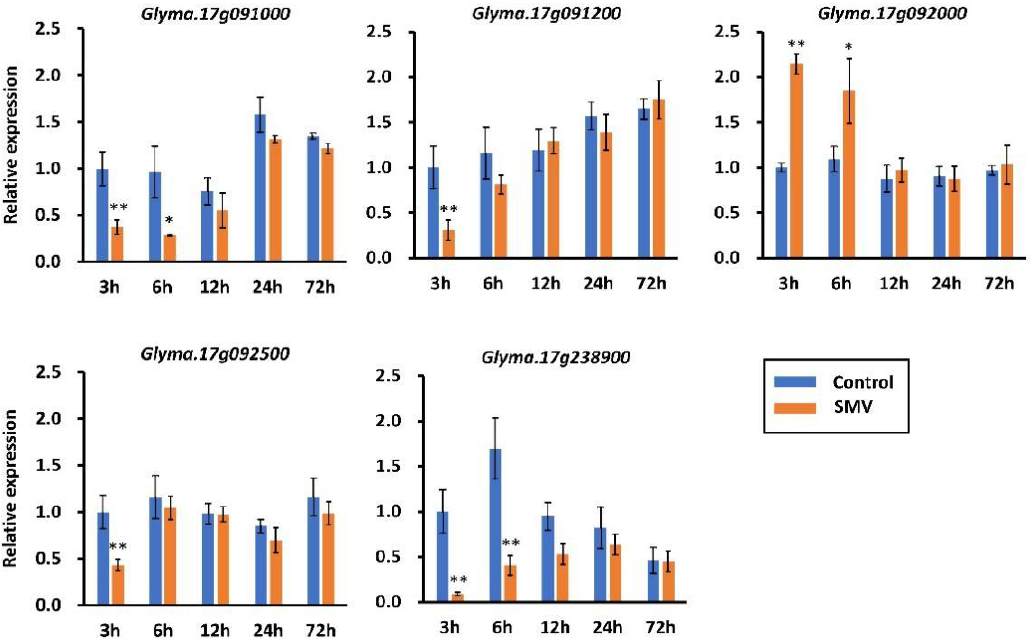
Figure 4. Expression profiling of candidate genes for resistance to seed coat mottling in soybean cultivar SN14 in response to SMV N3 strain. The y -axes indicate the relative expression levels between samples infected with SMV and control samples inoculated with PBS buffer; the x -axes indicate the time points post-inoculation; the * and ** indicate significant differences at p < 0.05 and p < 0.01, respectively, based on Student’s two-tailed t -test using SPSS 12.0.